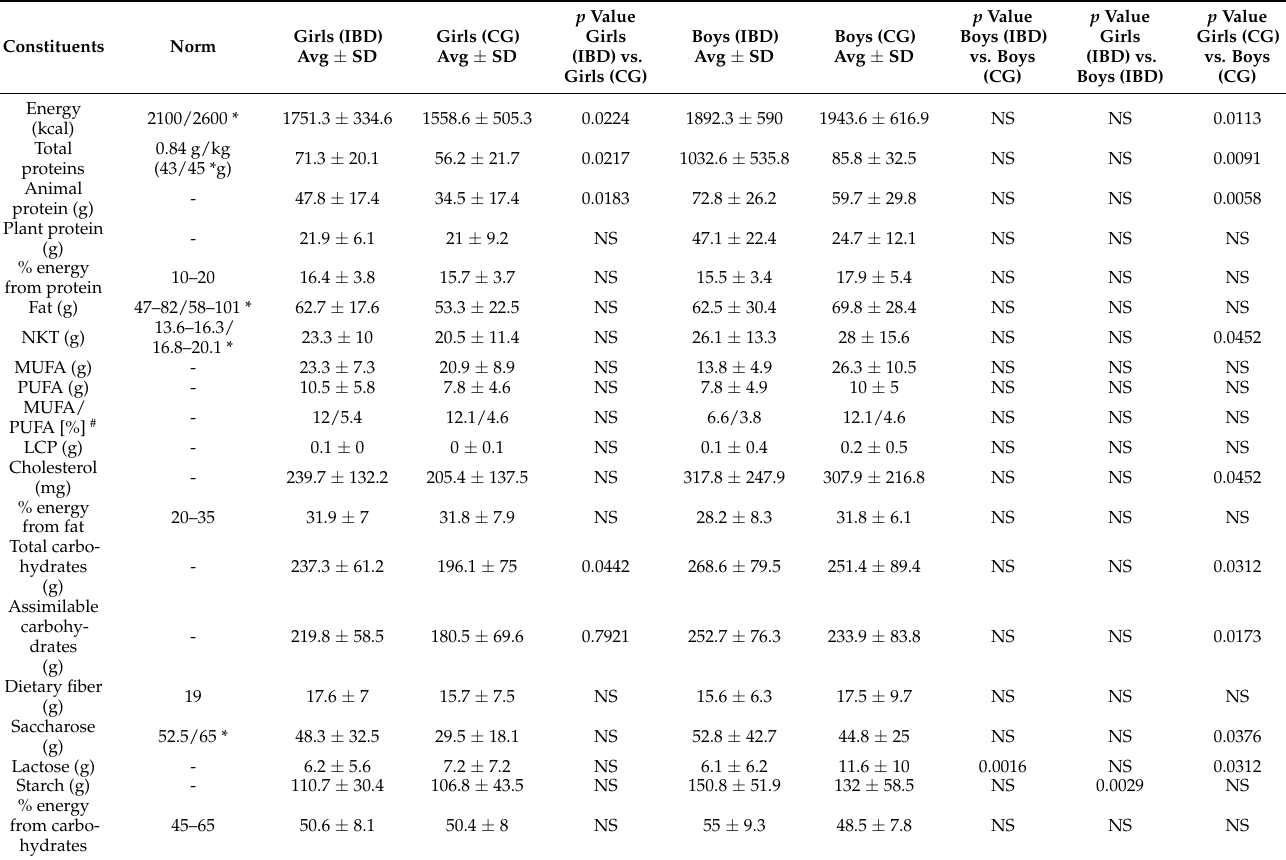
Table 2. The comparison of mean nutrient consumption (proteins, fats, and carbohydrates) in IBD and CG by gender.